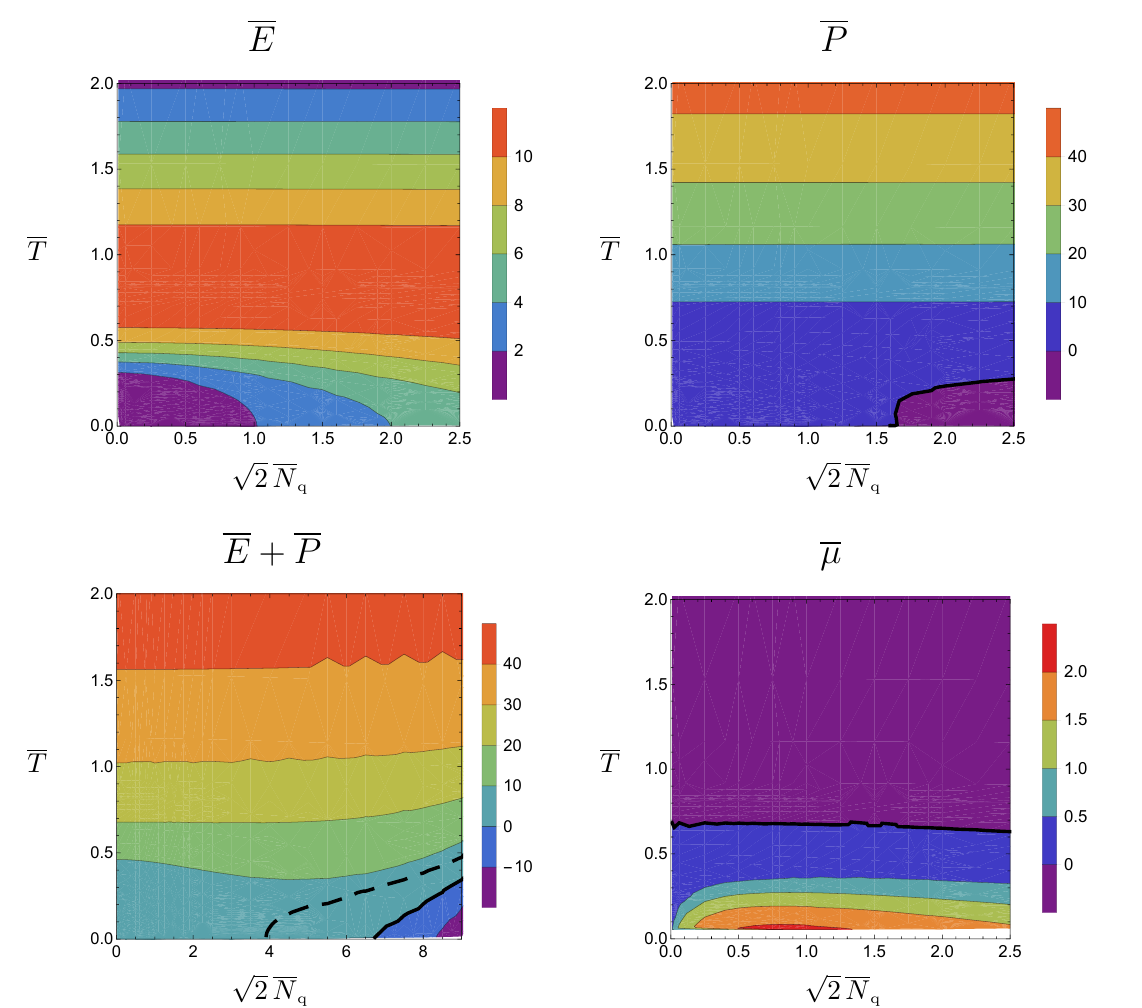
Figure 13. Dimensionless energy density, pressure, enthalpy and chemical potential, as de(cid:12)ned in (4.24) , (4.26) and (4.28) . The thick, black, continuous curves indicate the locus where the corresponding quantity changes sign. For comparison, in the E + P plot we have also indicated with a thick, black, dashed curve the locus where E + 3 P changes sign (see also (cid:12)gure